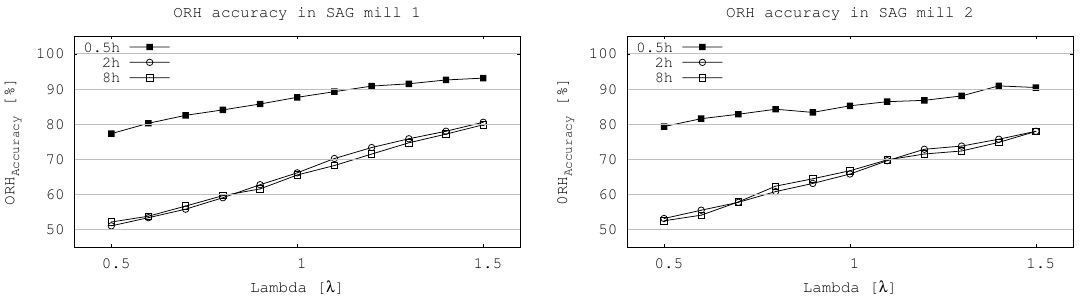
Figure 3. Accuracy of operational relative-hardness prediction at different time support as function of lambda ( λ ) on both SAG